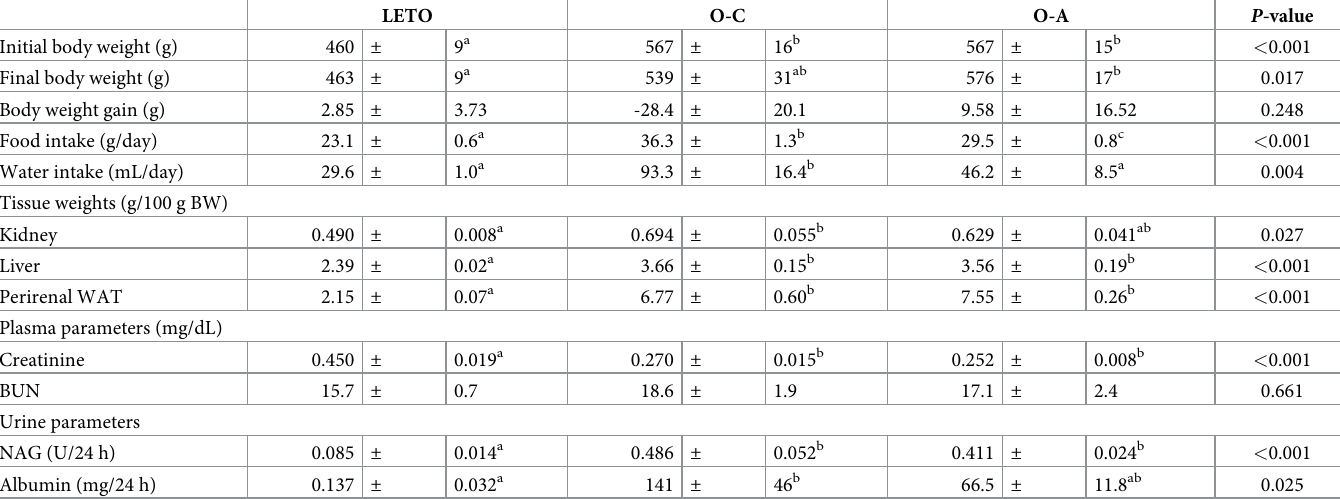
Table 2. Body weight, food and water intake, tissue weights, and plasma and urine parameters of the experimental rats.